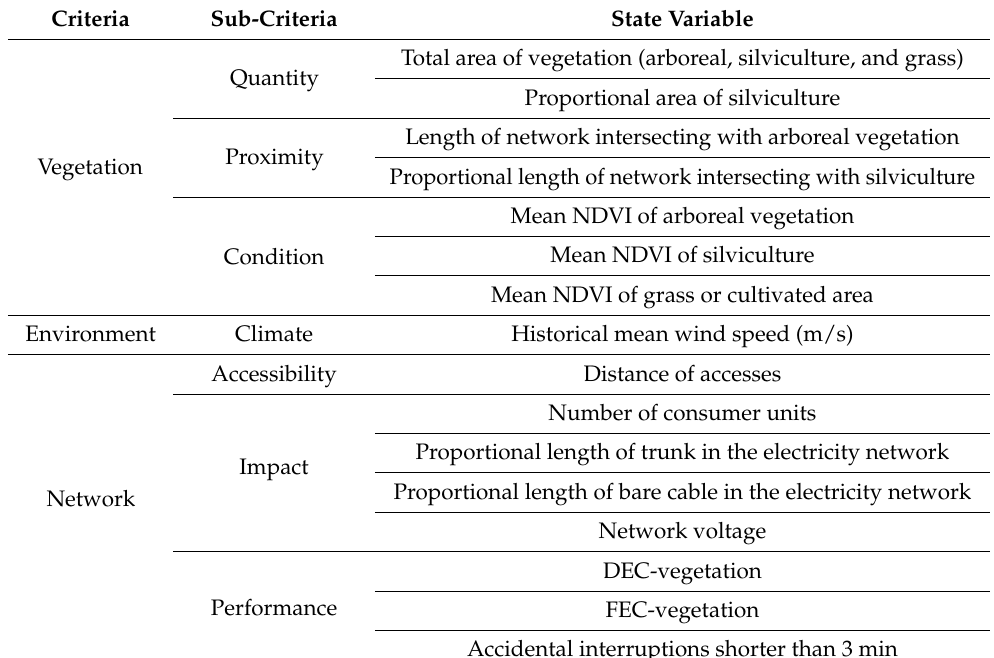
Table 4. Criteria, sub-criteria, and state variables defined to prioritize vegetation mowing in rural